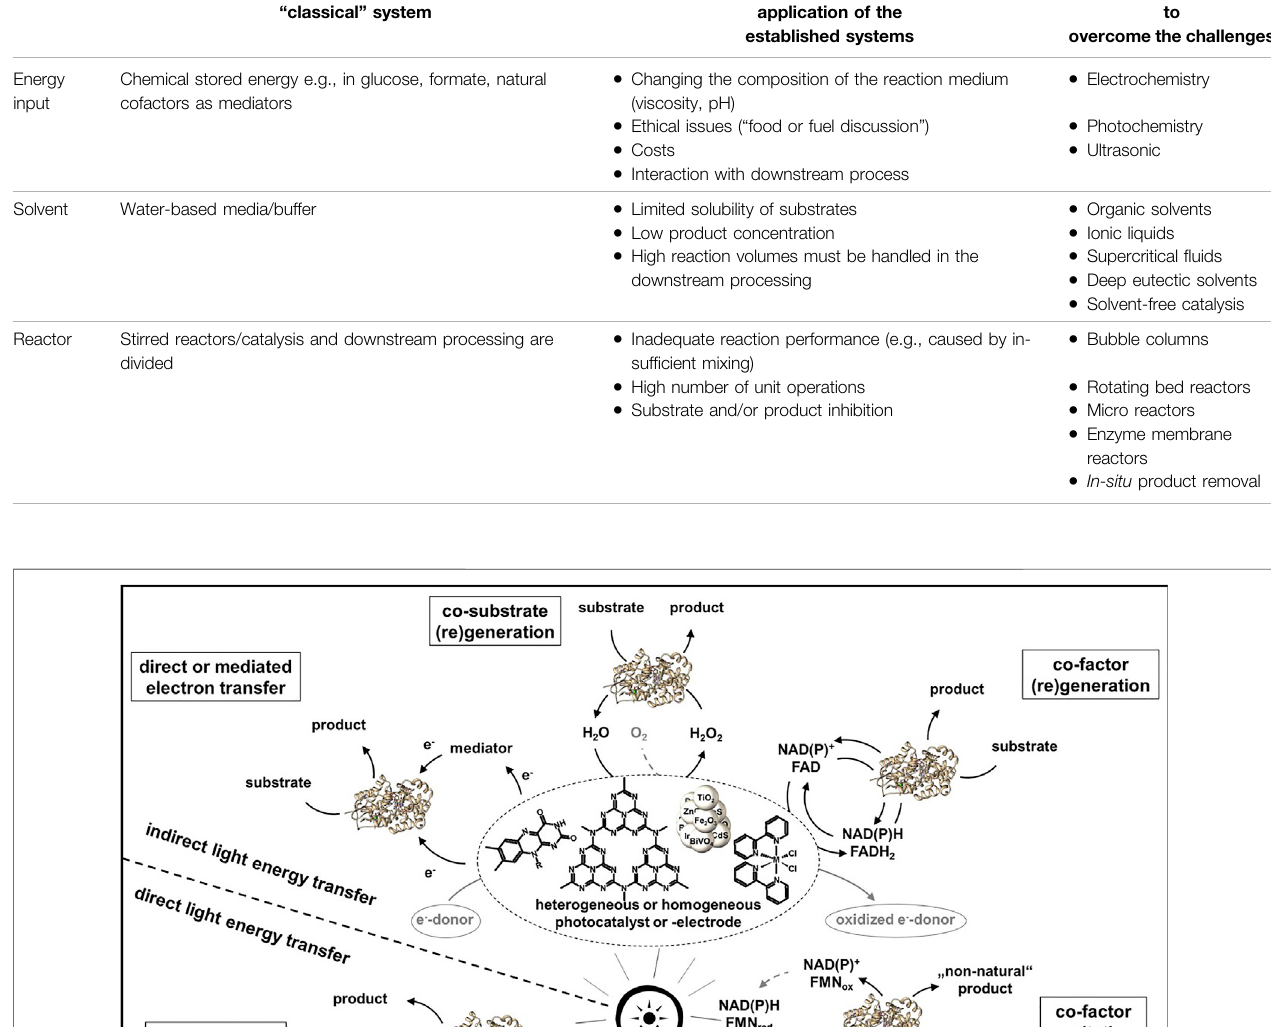
TABLE 1 | Examples of process intensi fi cation approaches in enzyme catalysis. Topic